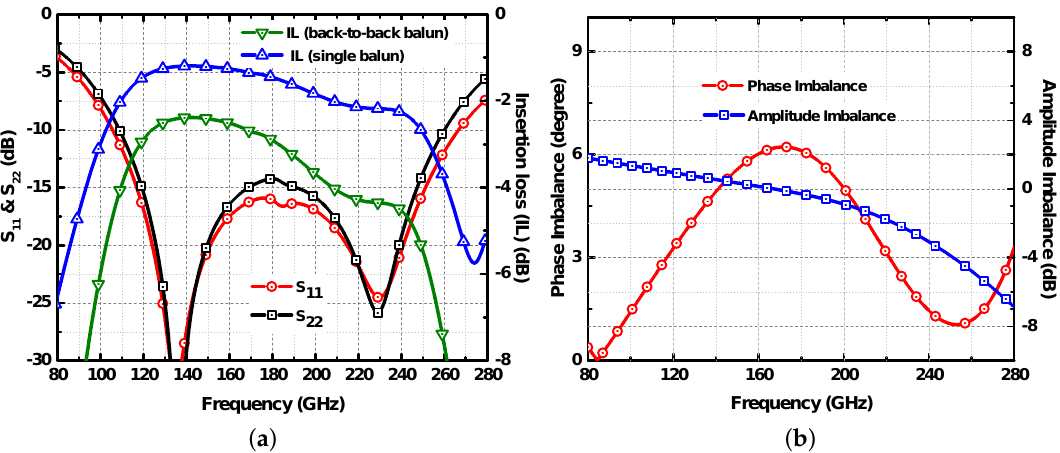
Figure 10. Simulated S 11 , S 22 insertion loss ( a ) and amplitude and phase imbalance ( b ) of the re-scaled asymmetric coupled line balun.